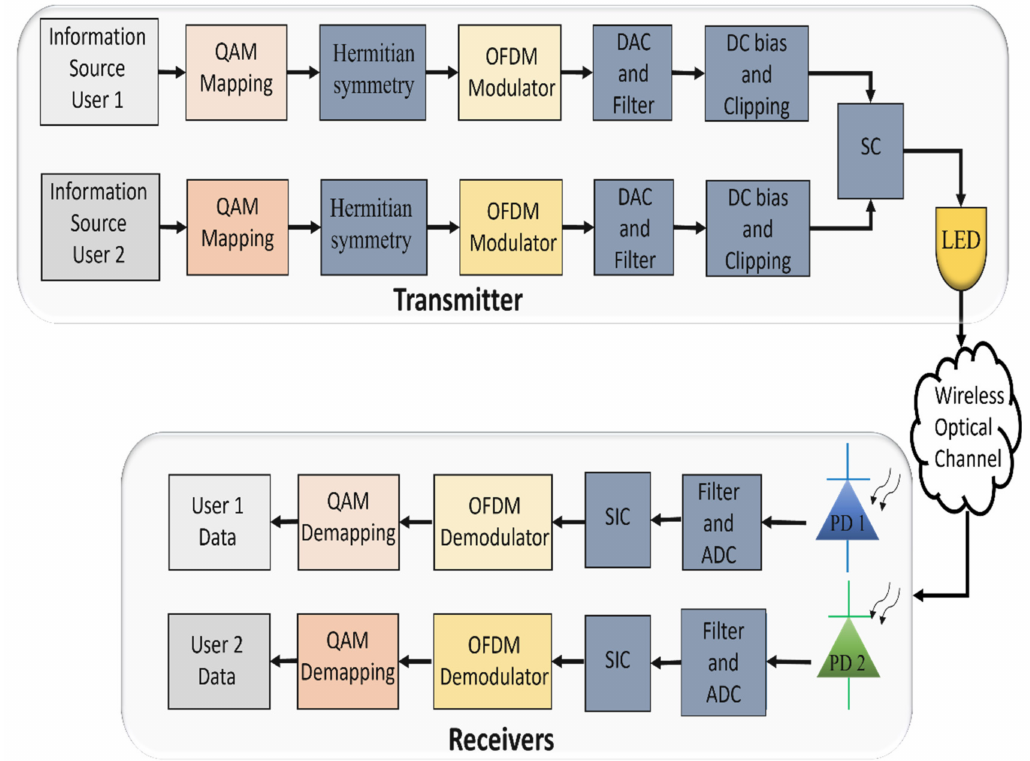
Figure 10. Block diagram of a two-user downlink DCO-OFDM-based PD-NOMA-VLC